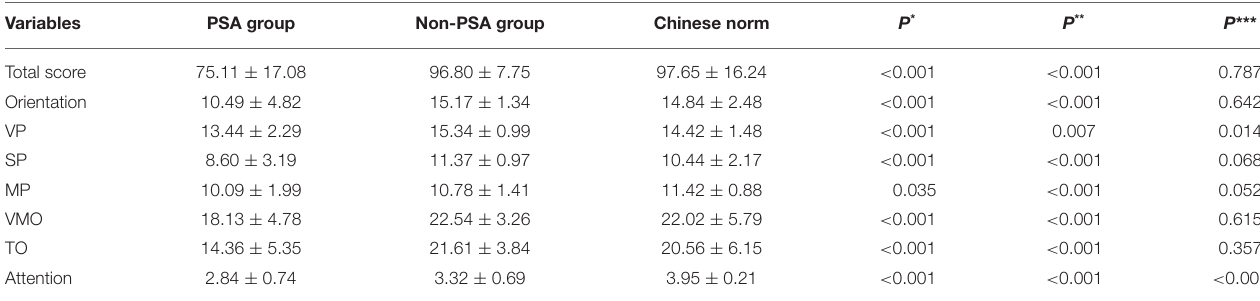
P * ,comparisonbetweenPSAgroupandnon-PSAgroup;P ** ,comparisonbetweenPSAgroupandChinesenorm;P *** ,comparisonbetweennon-PSAgroupandChinesenorm.LOTCA, Loewenstein Occupational Therapy Cognitive Assessment; VP, visual perception; SP, spatial perception; MP, motor praxis; VMO, visuomotor organization; TO, thinking operations; PSA, post-stroke